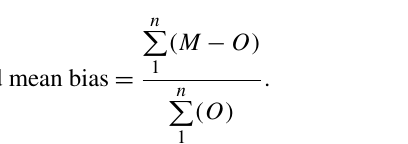
normalized mean bias